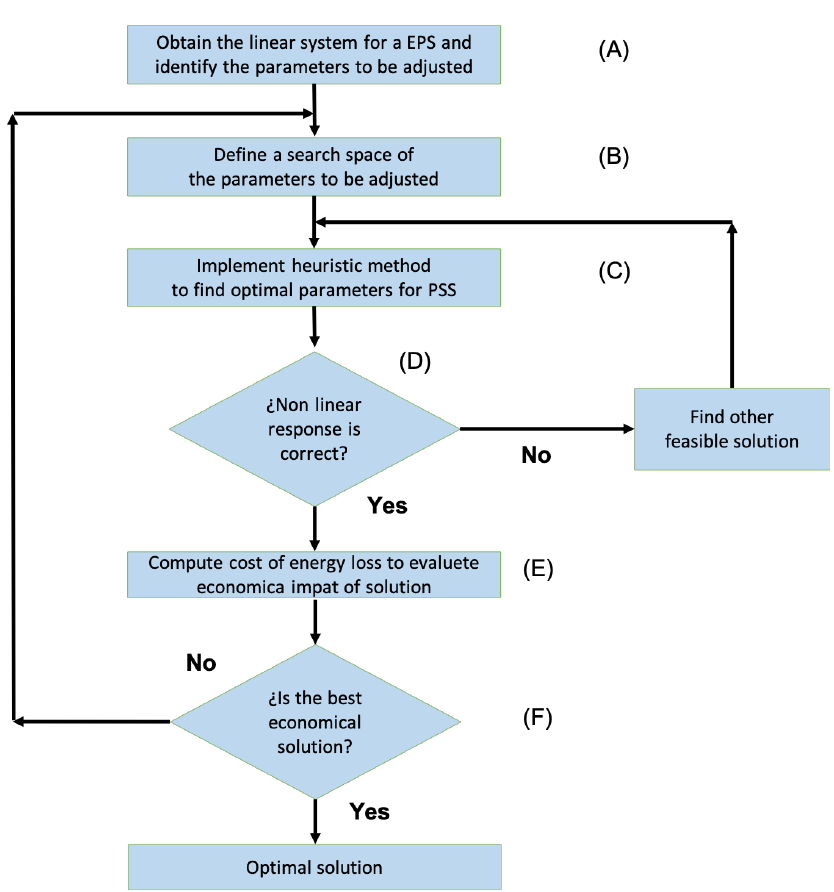
Figure 4. Proposed Method for heuristic-stochastic